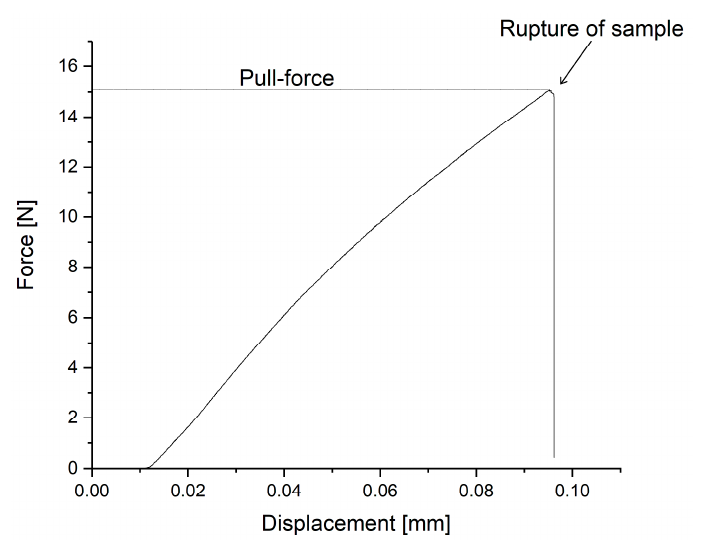
Figure A1. Example of the measurement results obtained by the tensile test and the deriving of the pull-force.